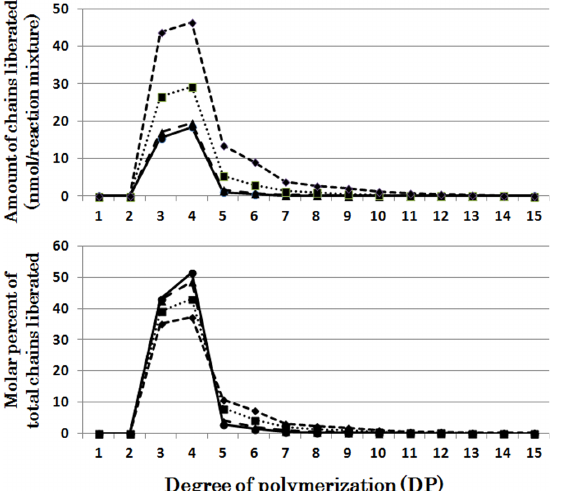
OsISA3 with amylopectin were dramatically different from those with phytoglycogen (S3 Fig).